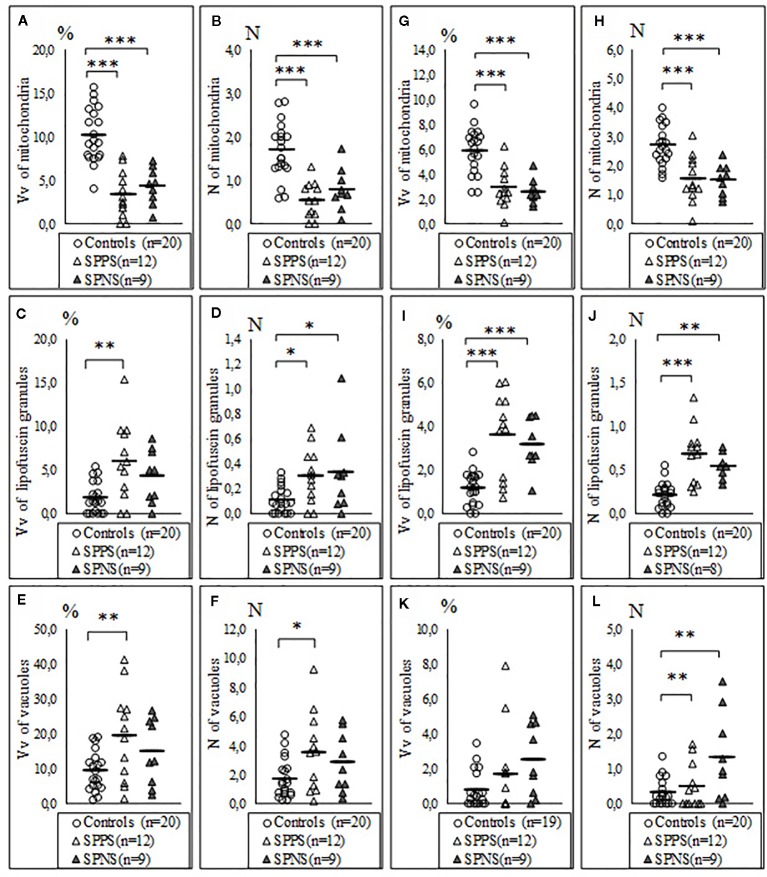
Individual and mean values for Vv and N of mitochondria (A, B), lipofuscin granules (C, D), vacuoles (E, F) in microglia adjacent to oligodendrocytes, in oligodendrocytes adjacent to microglia (G–L) for the control group, the subgroup with predominantly positive symptoms (SPPS) and the subgroup with predominantly negative symptoms (SPNS). *p < 0.05, **p < 0.01, ***p < 0.001.